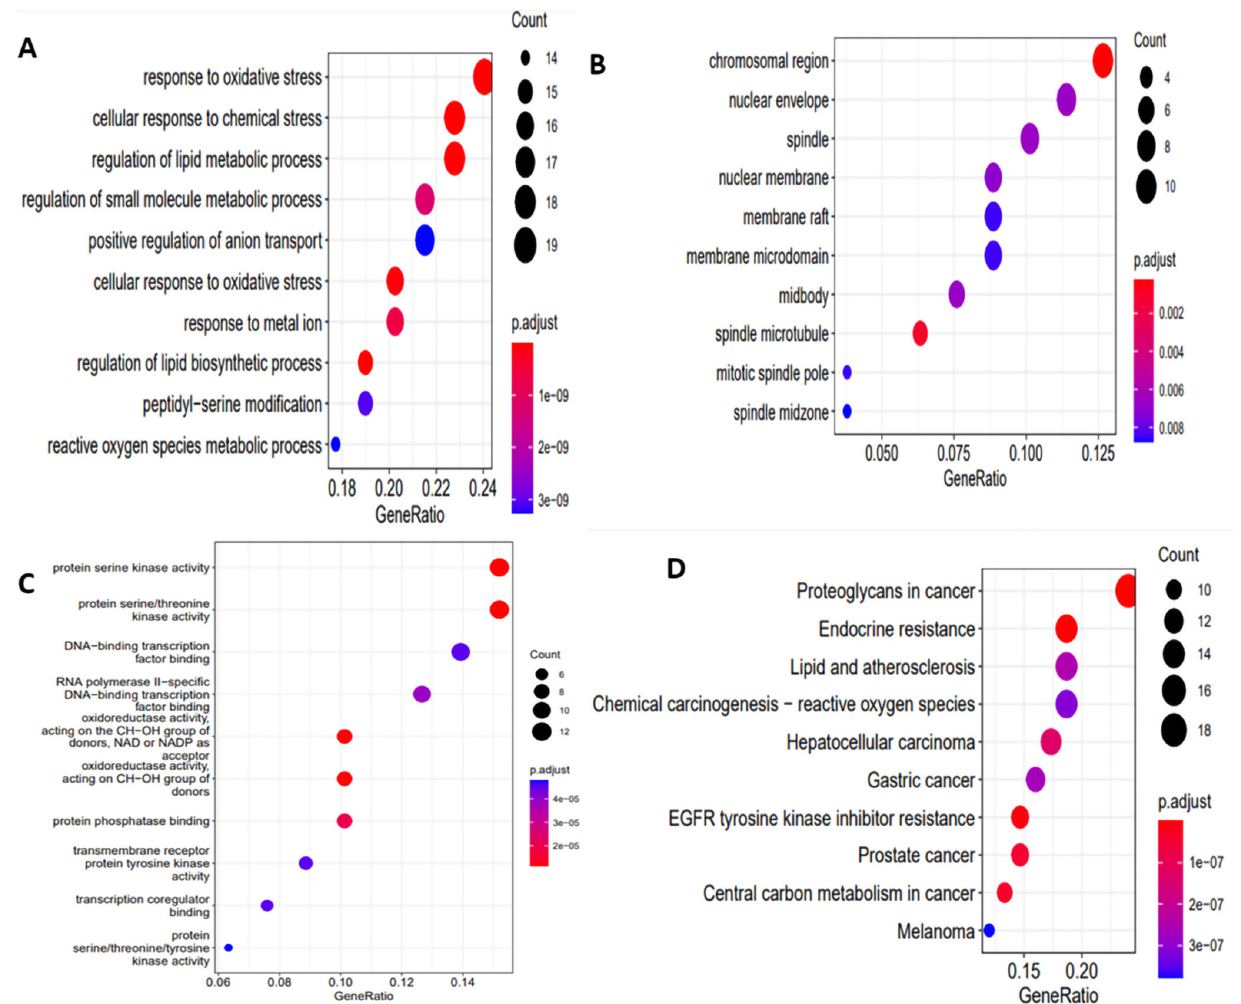
Figure 3. GO and KEGG enrichment analysis of key targets. ( A ) Biological process, ( B ) cellular components, ( C ) molecular functions, and ( D ) enriched KEGG pathways of key targets.